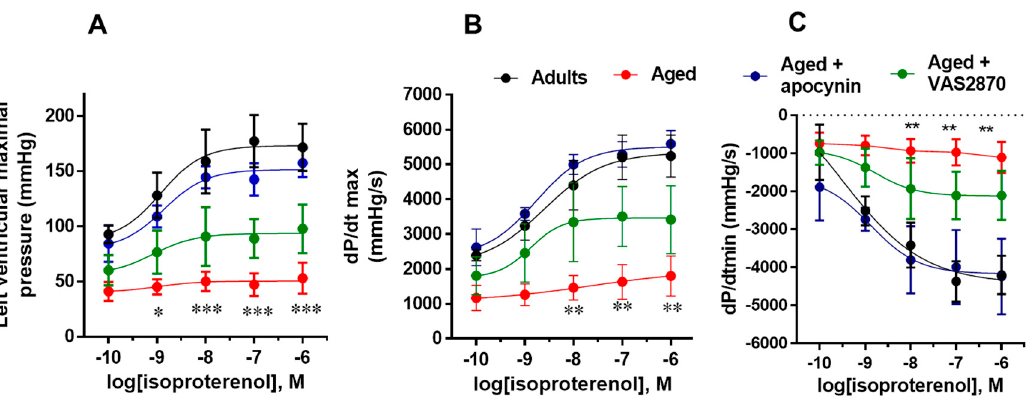
Figure 1. Heart function in the Langendorff preparation. Adult and aged isolated rat hearts were challenged with increasing concentrations of isoproterenol. Contractility was evaluated as developed pressure, dP/dt max and lusitropy as dP/dt min . Aged hearts were treated with NOX inhibitors apocynin (100 µmol/L) or VAS2870 (20 µmol/L). N = 5 hearts each group. Values are presented as mean ± standard error; n = 5. * p < 0.05, ** p < 0.01 and *** p < 0.001 vs. corresponding control.